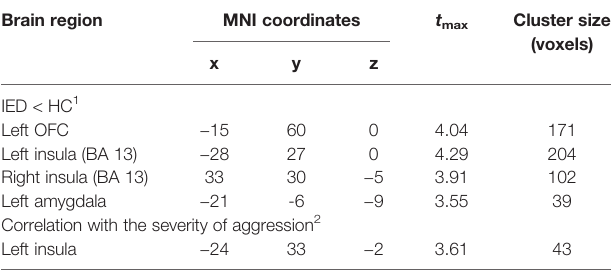
TABLE 3 | Differences in gray matter volume between the IED and control groups and brain regions negatively correlated with the severity of aggression. Brain region MNI